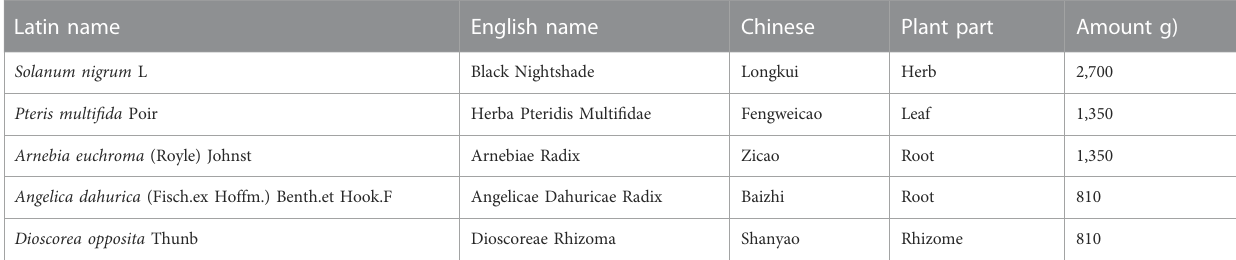
TABLE 1 Information of components in